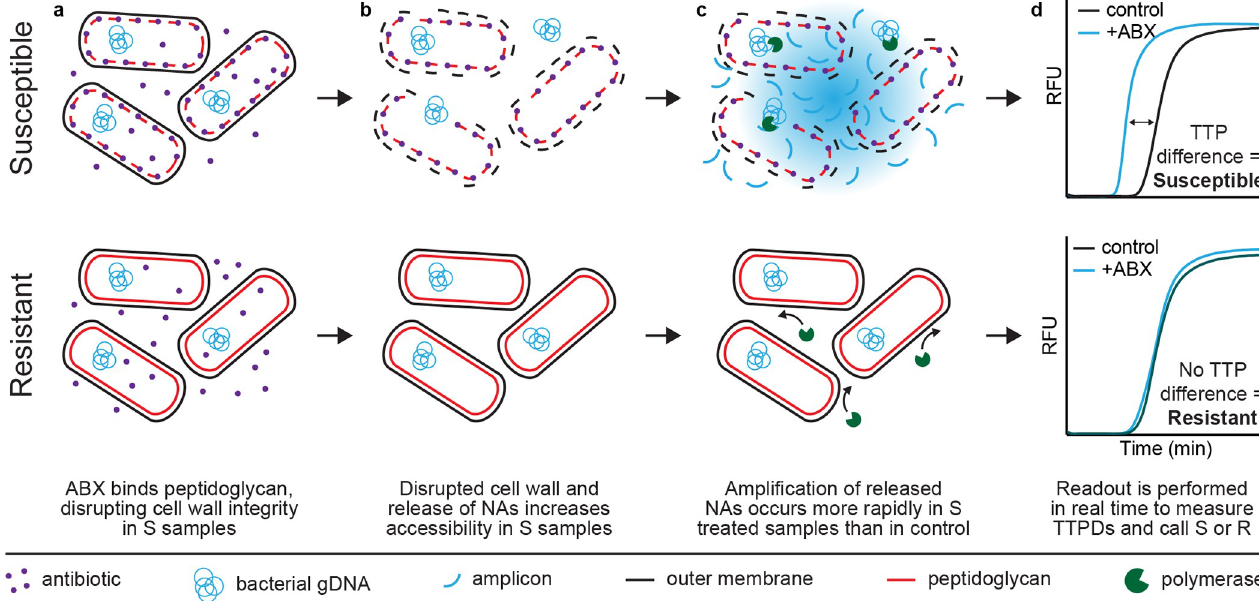
Fig 1. Overview of the pol-aAST shown for susceptible and resistant samples exposed to β -lactams. (a) Treated aliquots are exposed to a β -lactam. In susceptible samples, β -lactams compromise cell wall integrity. (b) NAs are released from compromised cells, increasing NA accessibility to polymerase. (c) Released NAs in the susceptible treated aliquot amplify faster than NAs from intact cells in the control aliquot, resulting in a difference in TTP. No difference in amplification between control and treated aliquots is observed in resistant samples. (d) TTPD between control and treated aliquots is used to assess susceptibility. ABX, antibiotic; AST, antibiotic susceptibility testing; gDNA, genomic DNA; NA, nucleic acid; pol-aAST, polymerase-accessibility AST; R, resistant; RFU, relative fluorescent units; S, susceptible; TTP, time-to-positive; TTPD, time-to-positive difference.